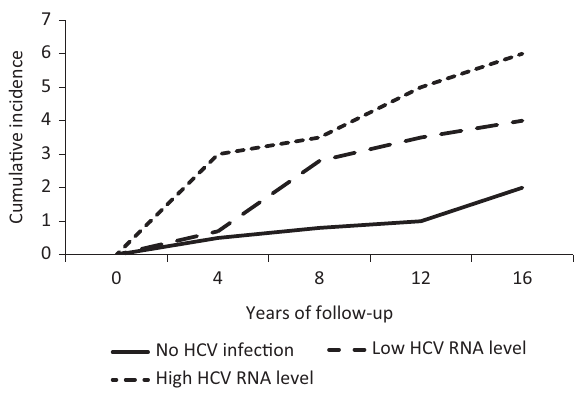
Figure 1. Cumulative risk of end-stage renal disease in patients affected by genotype 1 (24).